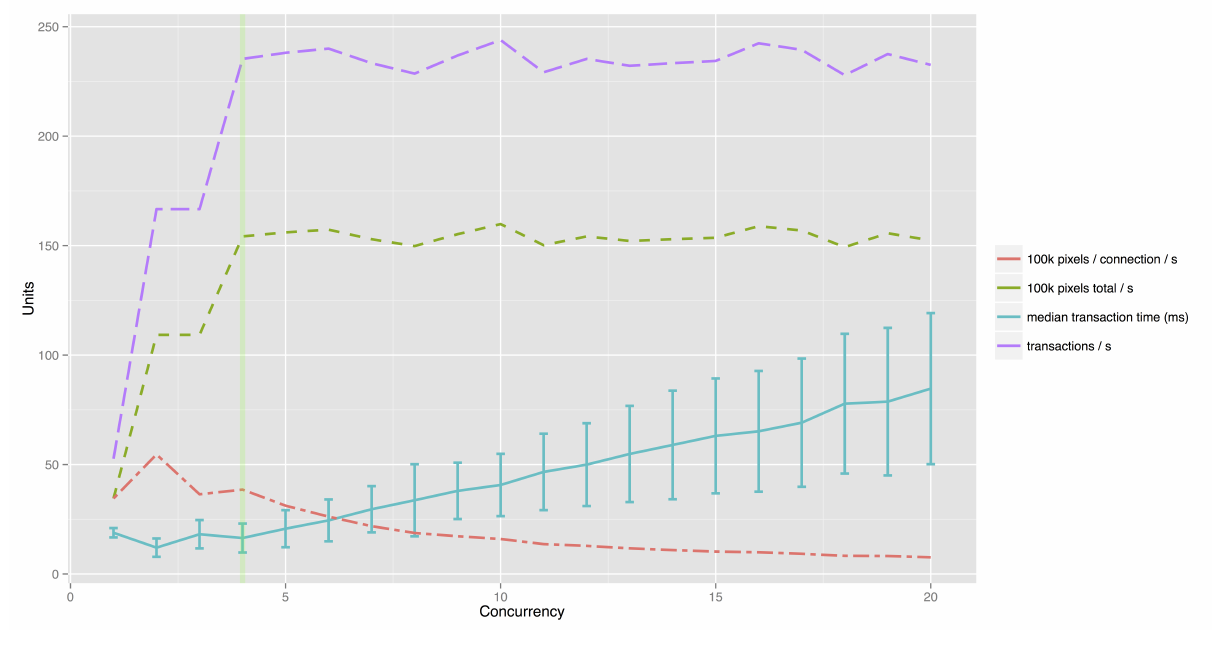
Figure 6. Plot of the values of Table 4 depicting the median response time in msec, including the standard deviation, as well as the transactions per second, pixels per second, and total and individual pixels per worker per second.